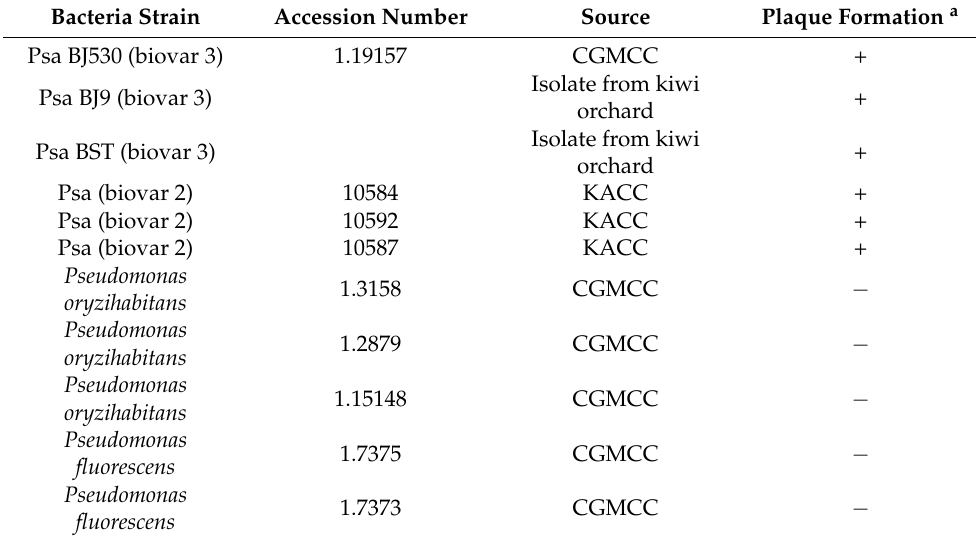
Table 2. Host range of phage